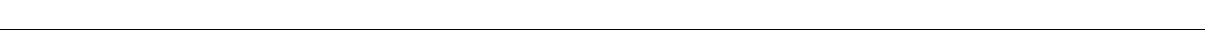
Fig. 2 Itch ubiquitylates SuFu through K63 linkage. a HEK293T cells were co-transfected with HA-Ub in the presence or absence of Flag-Itch or Flag- C830A. Cell lysates were immunoprecipitated with an anti-SuFu antibody, followed by immunoblotting with an anti-HA antibody to detect ubiquitylated forms. b Itch − / − MEFs were transfected with HA-Ub in the presence or absence of Flag-Itch or Flag-C830A. The assay was carried out as described in a . Wild-type (WT) MEFs were used as control to evaluate the basal ubiquitylation of endogenous SuFu. c , d In vitro translated 35 S-labelled SuFu WT ( c , d ) or SuFu K-less ( d ) was incubated alone or in combination with GST-Itch for the indicated times. The ubiquitylated forms were detected by fl uorography. e Schematic representation of SuFu protein showing its lysine residues involved in Itch-dependent ubiquitylation. f , g Flag-SuFu WT or Flag-SuFu mutants were co-transfected in HEK293T cells with HA-Ub in the presence or absence of Myc-Itch. The assay was carried out as described in a . h HEK293T cells were transfected with HA-Ub and Flag-SuFu in the presence or absence of Myc-Itch. Transfected cells were treated with MG132 (50 µ M for 4 h) to enrich for ubiquitylated proteins. The assay was carried out as described in a . i HEK293T cells were transfected with Flag-SuFu in the presence or absence of increasing amount of Myc-Itch. Total protein levels were analysed by immunoblotting. j HEK293T cells were transfected in the presence or absence of increasing amount of Myc-Itch. Total protein levels were analysed by immunoblotting. k Immunoblotting analysis of SuFu and Itch proteins in HEK293T cells transfected with control (siCTR) or Itch siRNAs (siItch). β -Actin is shown as a control for loading (*non-speci fi c bands). l SuFu protein levels in WT MEF or Itch − / − MEF cells treated with cycloheximide (CHX, 100 µ g/ml) at different time points. m Puri fi ed recombinant proteins wild-type Ub or Ub mutants K48 only (K48O), K48R, K63 only (K63O), K63R, or K-less were incubated with GST-Itch and in vitro translated 35 S-labelled SuFu for the indicated times. Ubiquitylated SuFu was detected by fl